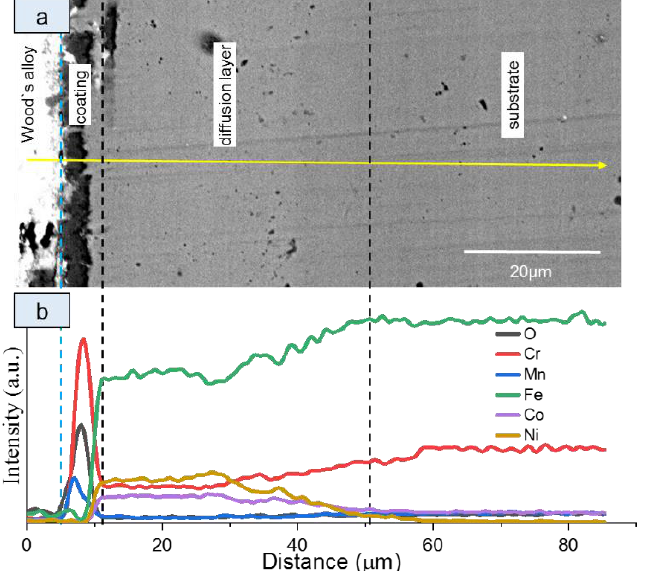
Figure 6. SEM image of cross-section ( a ) and element distribution ( b ) of the δCo/δMn = 1.5/0.5 μm coating after the heat resistance test. The yellow arrow indicates the line along which the EDX spectra were collected and their direction.